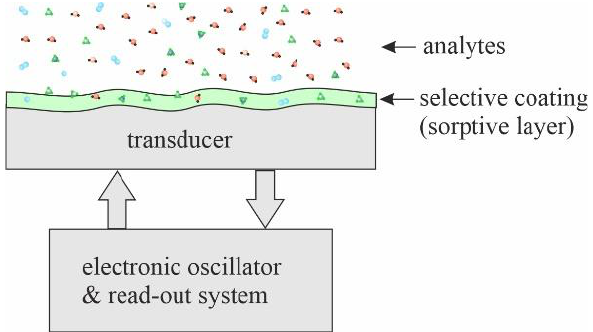
Figure 1. The basic principle of operation of an acoustic wave chemical gas sensor. There are many types of acoustic wave transducers differing in the type of acoustic wave propagating and the method of its excitation. The most widely used in gas sensing applications are transducers with bulk acoustic wave, Rayleigh and Love-type surface acoustic waves, and plate waves [33]. A general scheme of the construction of these transducers and the wave propagating modes are shown in Figure 2.